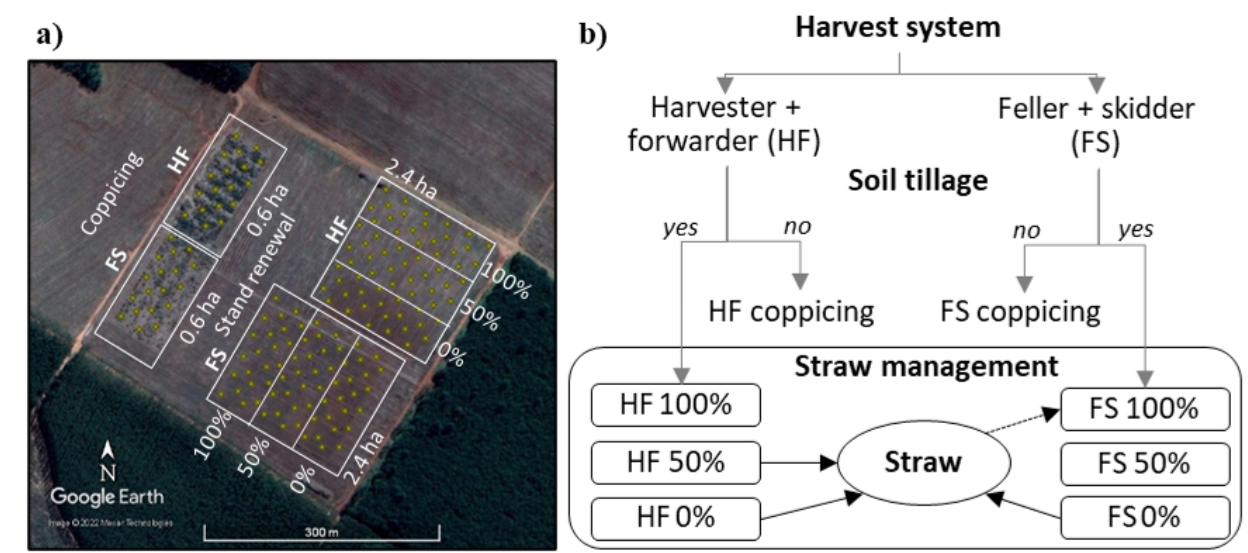
Figure 1. ( a ) Location of the harvester + forwarder (HF) and feller + skidder (FS) treatments in coppicing areas and stand renewed areas with different eucalypt straw levels (100, 50 and 0%). Yellow dots represent the place of soil penetration resistance measurements. ( b ) Flowchart illustrating the scheme of treatments. The solid and dashed black arrows indicate that the eucalypt straw was removed or added before soil tillage in renewal areas,